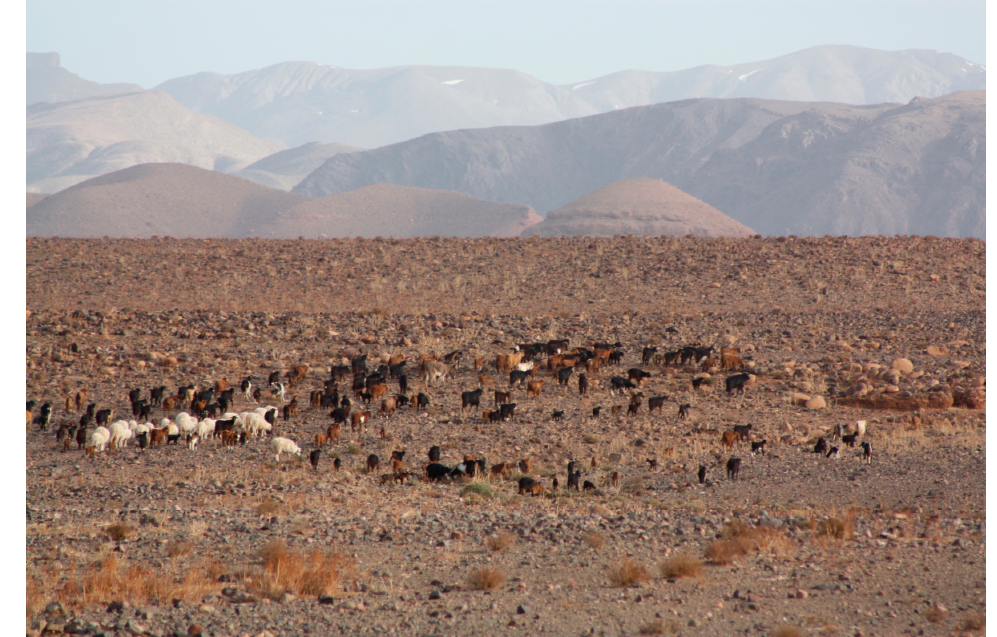
Figure 4. Herders and semi-nomadic groups from the Atlas Mountains with goats and sheep using the area on a reciprocal basis under Amazigh institutions. (Photo: Sarah Ryser 2017).